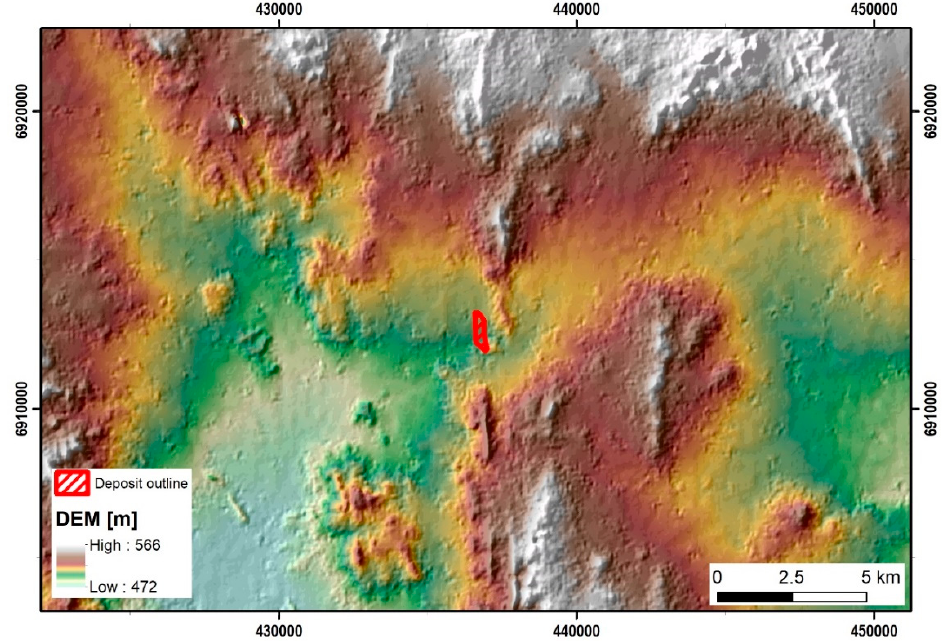
Figure 4. DEM of the Garden Well area showing general physiography [18] and Regis Resources). The outline of the Garden Well deposit is shown.